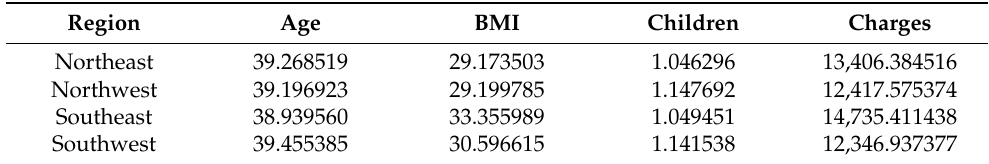
Table 2. Relationship between the region and charges.